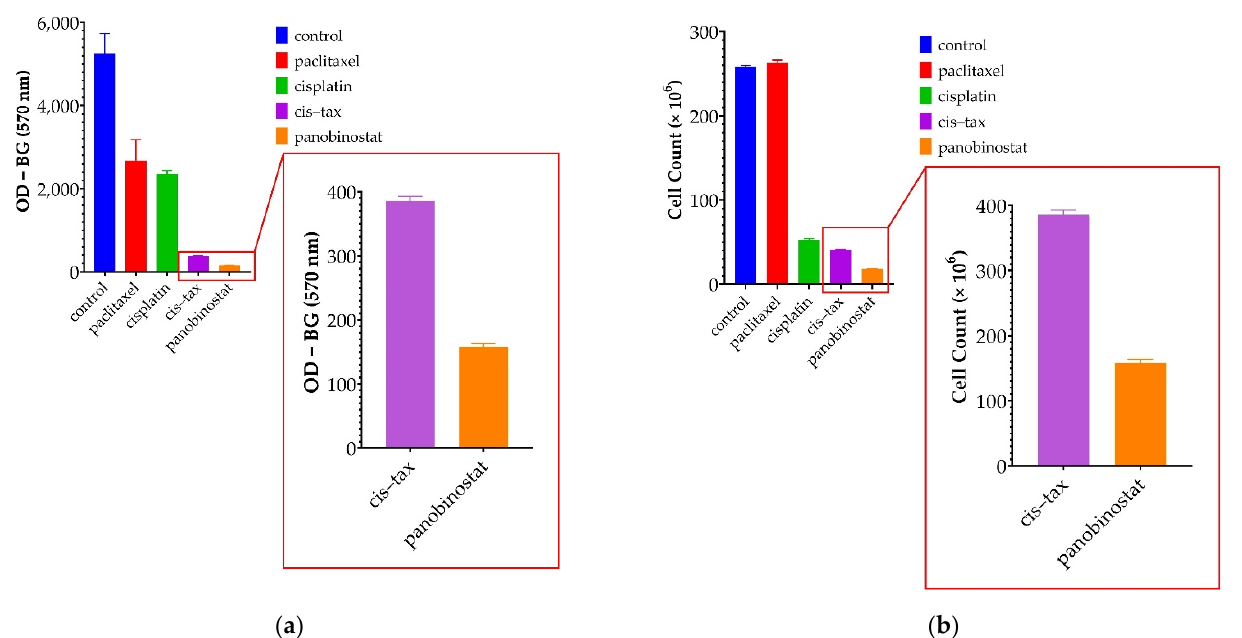
Figure 4. Viability assay of Caov-3 spheroids on day 3 following treatment. ( a ) In this MTT assay measuring the mitochondrial activity of the cells, optical density was used to represent the viability of the cells. Viability assays confirmed that panobinostat is more cytotoxic when compared to the control ( p = 0.009) than either of the single agents, cisplatin ( p = 0.03) or paclitaxel ( p = 0.06). Although the classic combination of cisplatin–paclitaxel was effective in this assay when compared with the control ( p = 0.01), the epigenetic therapy with panobinostat was twice as cytotoxic when compared directly to cisplatin–paclitaxel ( p = 0.001) and over ten times as toxic as single-agent chemotherapy (cisplatin p = 0.003, paclitaxel p = 0.04) ( n = 2) ( b ) Direct cell counts were utilized to confirm MTT findings. Paclitaxel was no more cytotoxic than the control ( p = 0.278). All other treatments demonstrated cytotoxicity ( p < 0.0001); furthermore, panobinostat was significantly more cytotoxic than all the other treatments ( p < 0.001) ( n = 2).